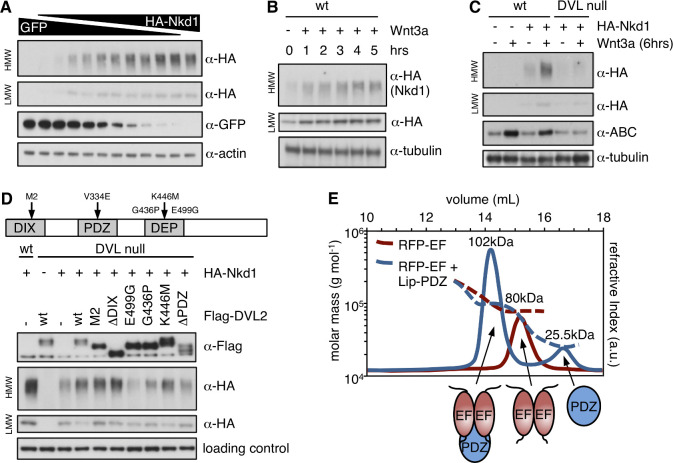
HisC aggregation is promoted by DVL2.(A–D) Western blots monitoring the formation of HisC aggregates in wt or mutant HEK293T cells dependent on (A) Nkd1 concentration, (B) duration of Wnt stimulation, (C) DVL or (D) complementation of DVL null cells by re-expression of wt or mutant DVL2 (E499G, G436P block DVL2 dimerization; K446M blocks Frizzled receptor binding) (Gammons et al., 2016a). (E) SEC-MALS, monitoring complex formation between purified recombinant RFP-NKD1-EF and Lip-DVL2-PDZ (as indicated by cartoons); numbers correspond to Mr values determined by MALS (expected: RFP-NKD1-EF dimer, 71.8 kDa; Lip-DVL2-PDZ, 22.0 kDa; complex, 93.8 kDa).